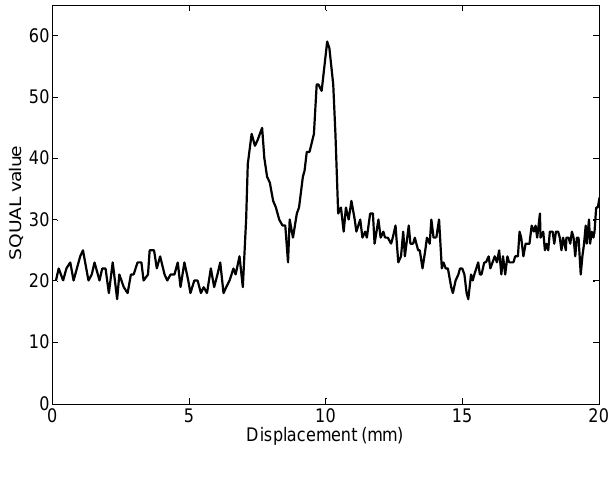
Figure 5. Dynamic evolution obtained from the SQUAL register when the optical mouse sensor is moving over a white paper with a transversal black line of 1.2 mm